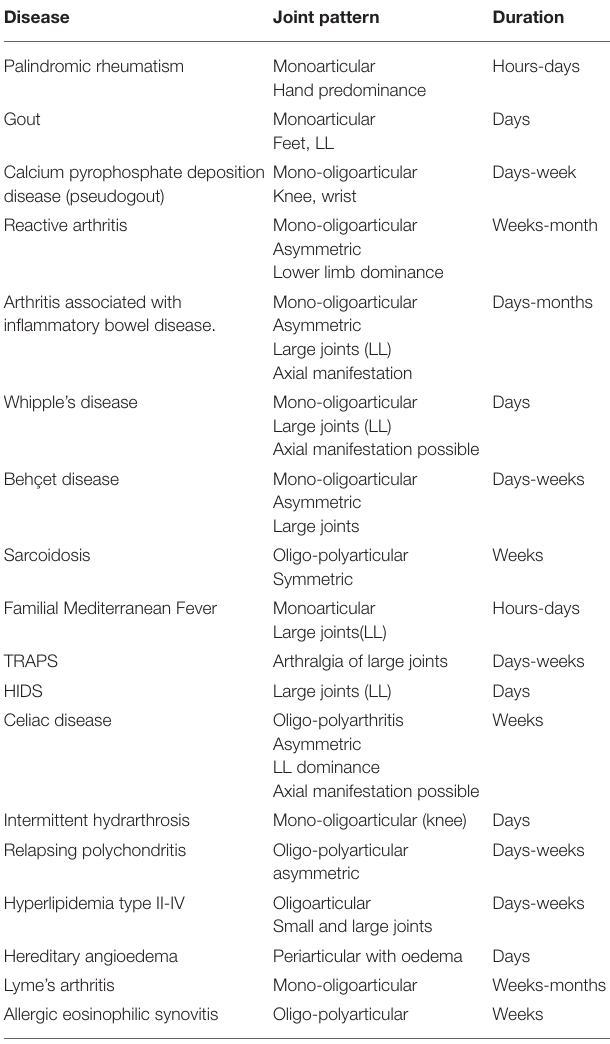
TABLE 1 | Differential diagnosis of intermittent